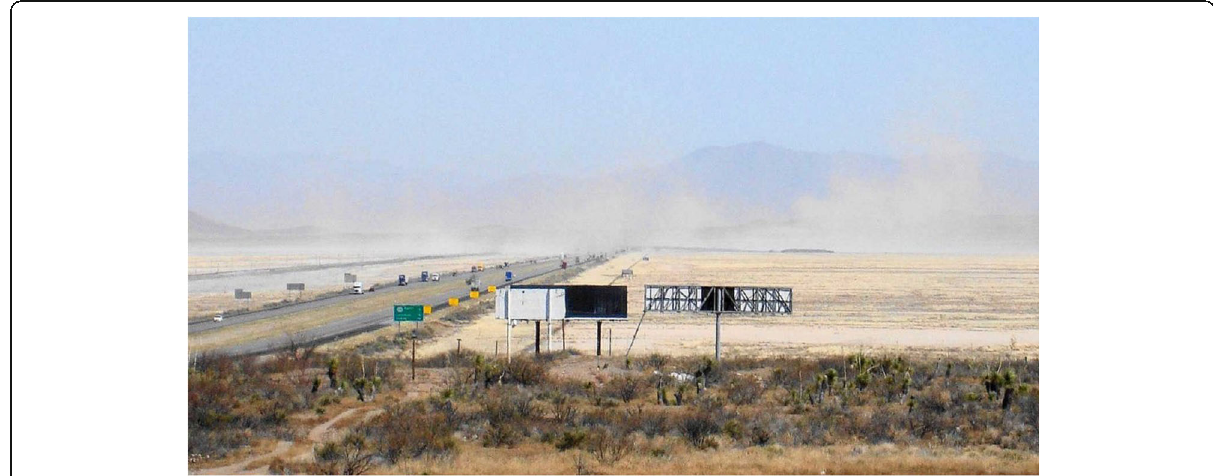
Fig. 2 Dust clouds blowing across Interstate Highway 10 on Lordsburg Playa while the highway is open to automobile and truck traffic, March 22,